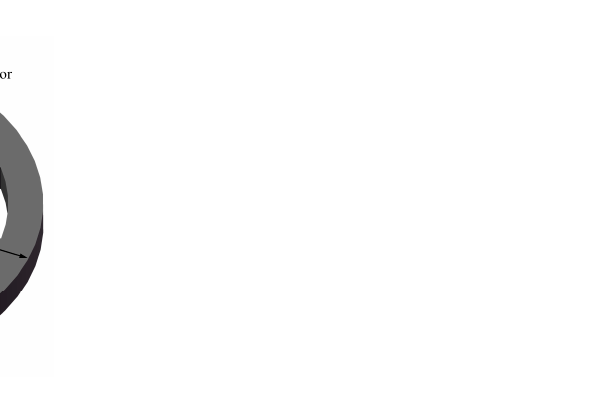
Figure 1. Topology of the slice rotor supported by one active magnetic bearing unit. x / y , radial direction; z , axial direction. Table 1. The parameters of the AMB system.